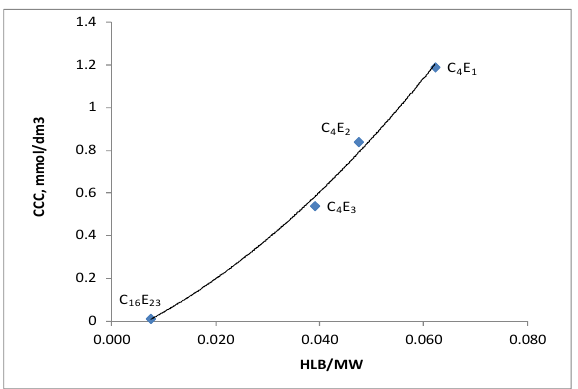
Figure 8. Effect of HLB/MW on CCC values for the polyglycol frothers.